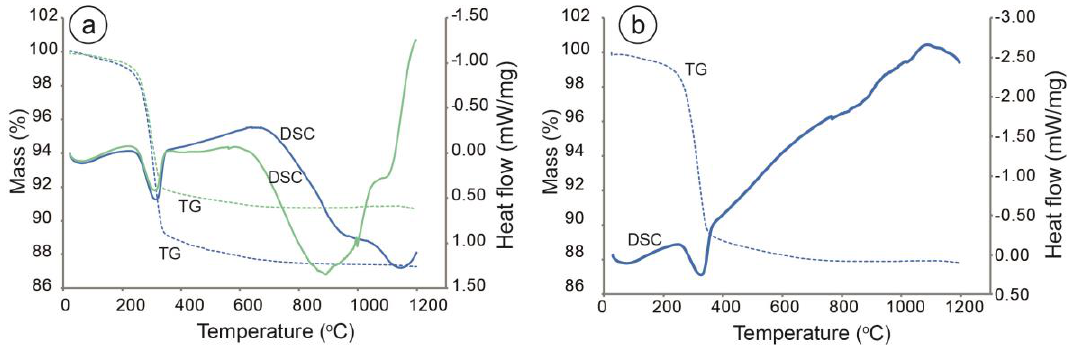
Figure 8. Thermogravimetric profiles of iron ore. ( a ) DSC/TG curves in environmental atmosphere of iron ore (in blue) and iron ore with quartz flux (in green). ( b ) DSC/TG curves in inert atmosphere. Mineralogical and textural features of slags combined with temperature-dependent reactions can be used to explore pyrometallurgical conditions in ironmaking from the Roman Age to the Middle Ages. The morphology and crystal size distribution indicate different smelting temperatures.